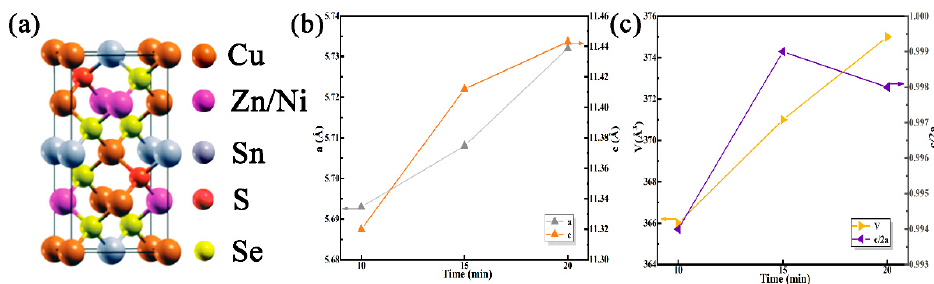
Figure 4. ( a ) Cell structure diagram of CNZTSSe film; ( b ) Lattice parameters a and c of CNZTSSe films obtained at the selenization time of 10, 15, and 20 min; ( c ) Unit cell volume (V) and η = c/2a of CNZTSSe thin films obtained at the selenization time of 10, 15 and 20 min.